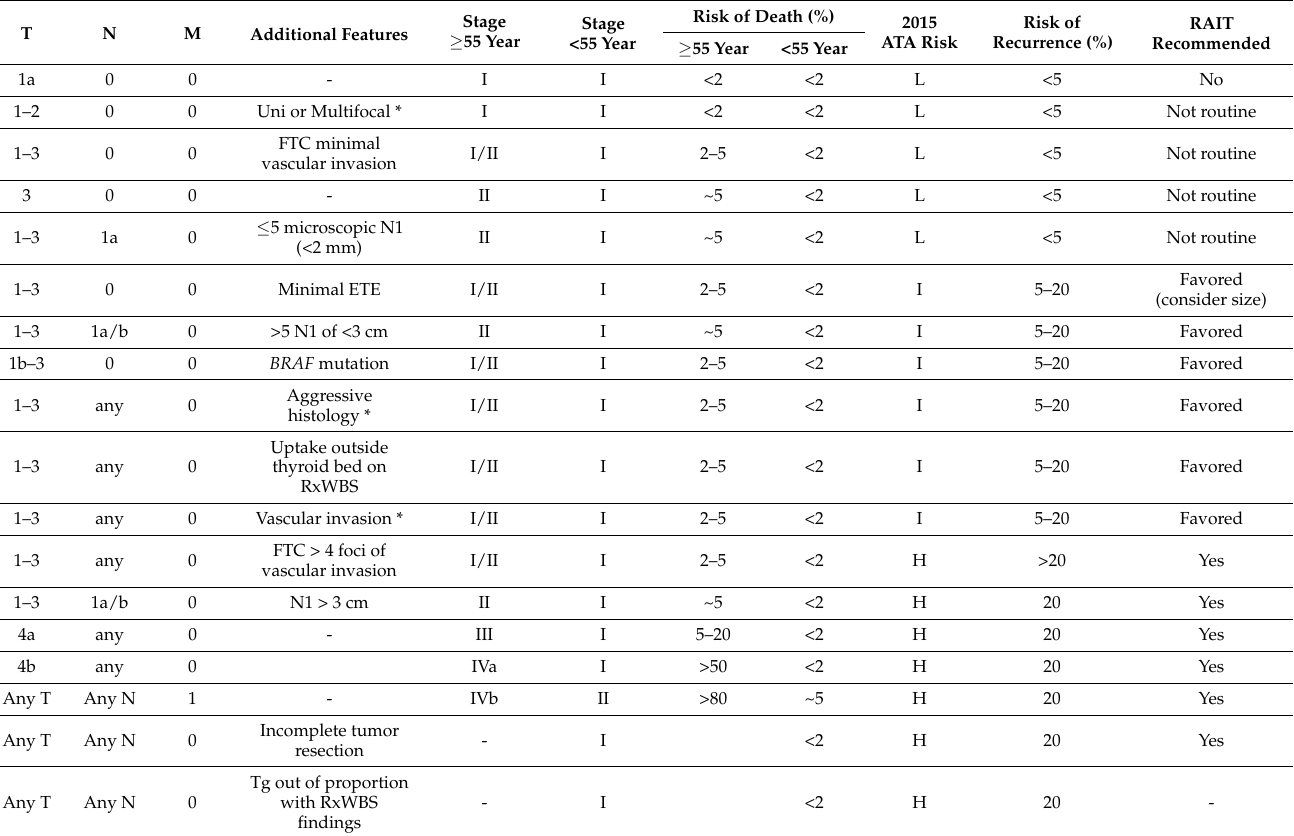
Table 1. AJCC TNM Staging 8th edition [12] and ATA risk classification and RAI recommendation according to ATA 2015